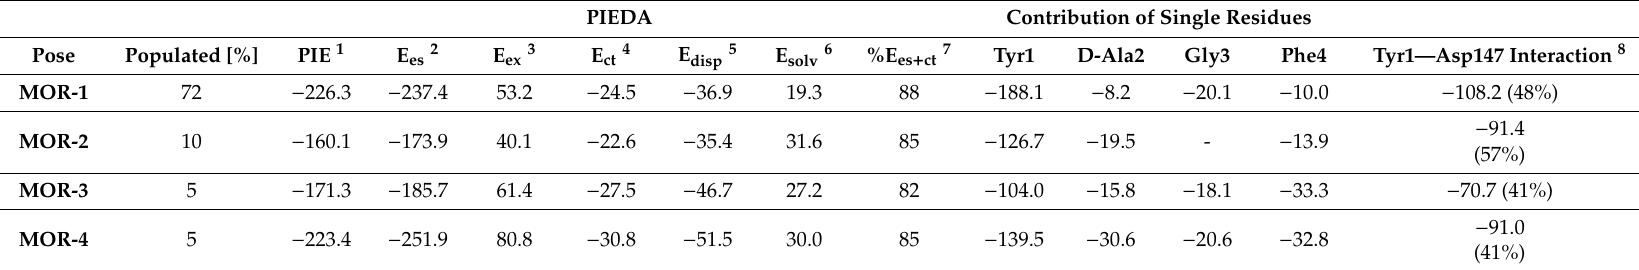
Table 2. Interaction energies (FMO PIEDA, kcal / mol) of the Tyr- d -Ala-Gly-Phe-fragment binding modes at MOR.